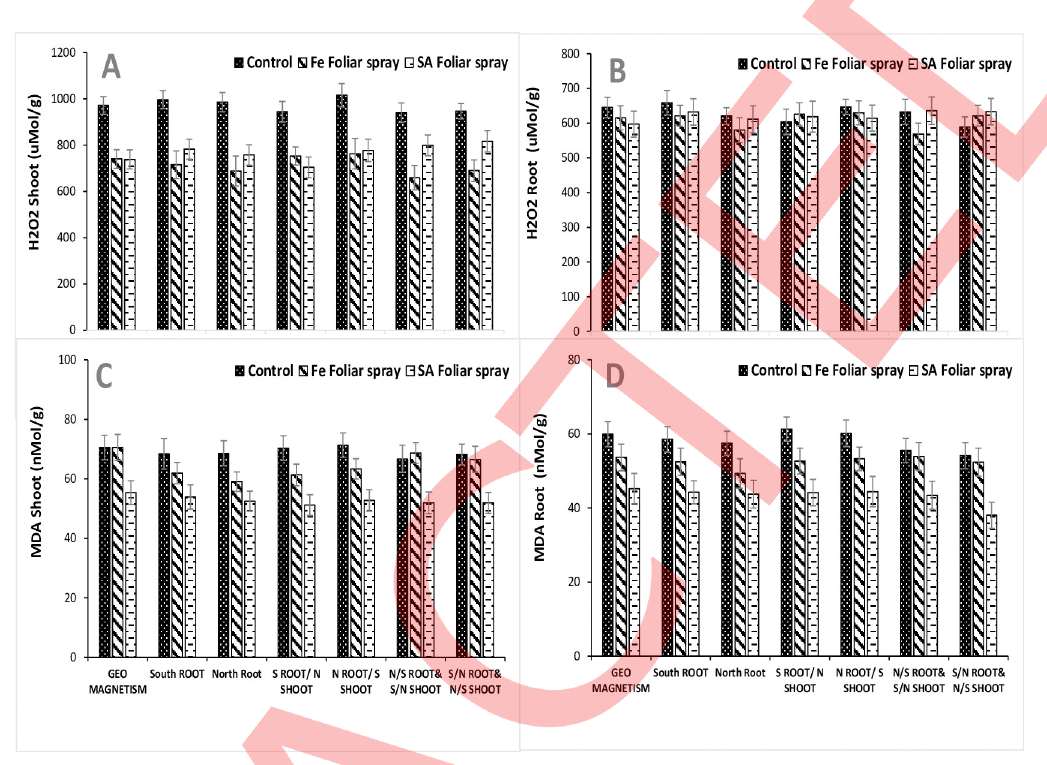
Fig 4. Changes in Oxidative stress Shoot H 2 O 2 (A), root H 2 O 2 (B), shoot MDA (C), root MDA (D) parameters of Pisum sativum under different magnetic treatments with Fe and SA Foliar